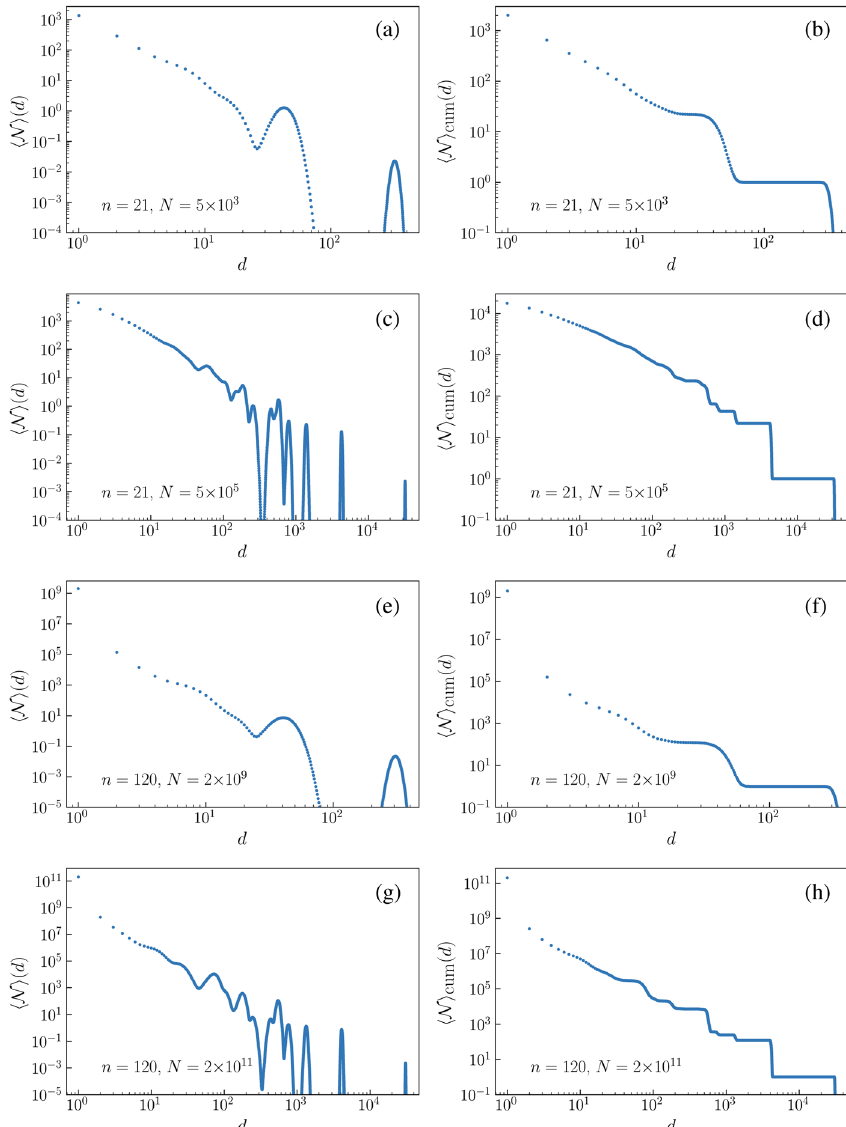
FIG. 8. Double logarithmic scale plots of (a),(c),(e),(g) the degeneracy distributions and (b),(d),(f),(h) the cumulative degeneracy distributions obtained for randomly generated input datasets of different sizes N for n ¼ 21 and n ¼ 120 . The specific sizes of input datasets for n ¼ 120 are chosen to produce distributions similar to those for n ¼ 21